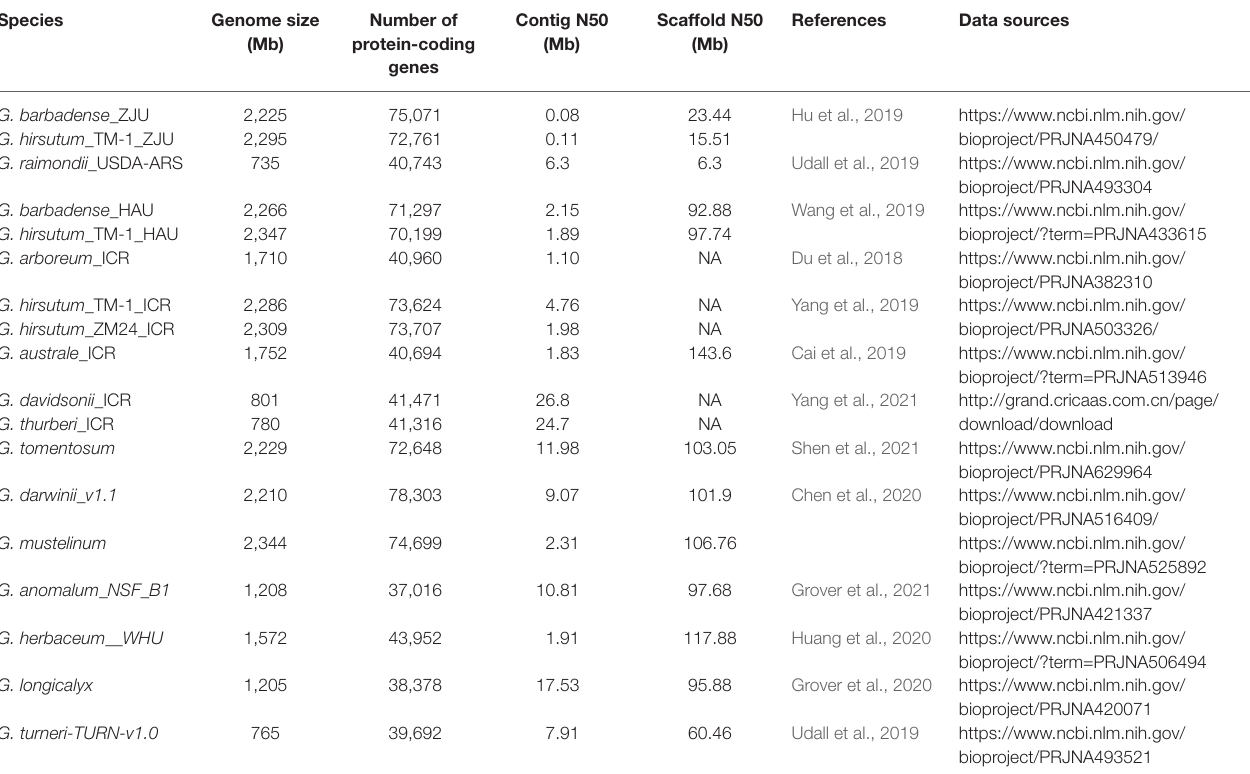
TABLE 1 | Summary of 18 cotton genome assemblies representing 14 Gossypium species.